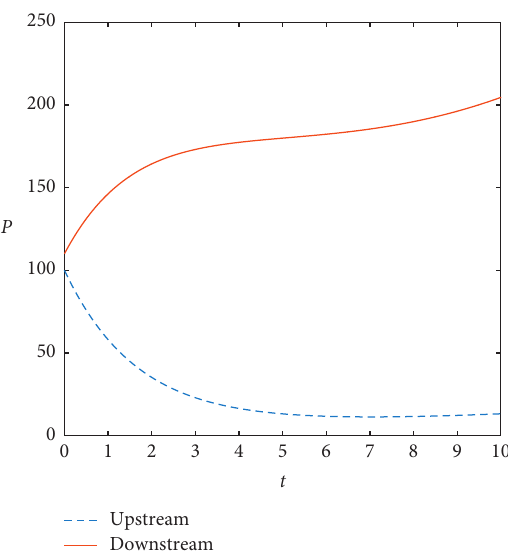
Figure 12: Optimal trajectory of pollution abatement investment under cooperation and non-cooperation when the planning period T ⟶ ∞ .